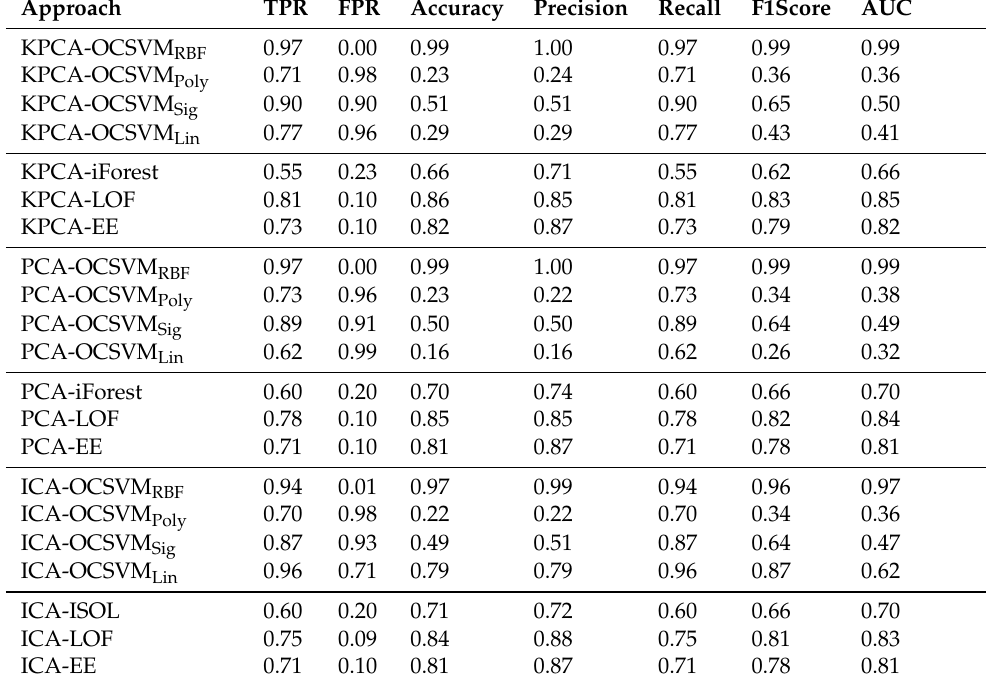
Table 5. Summary of advantages and shortcomings of four anomaly detection